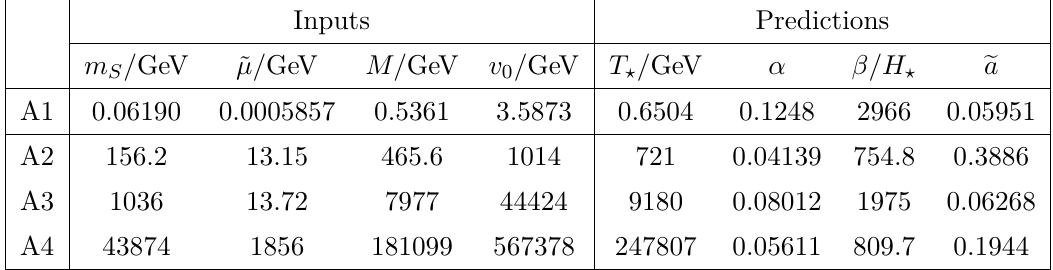
blue stars) whose parameters are in table 1. The corresponding GW spectra are